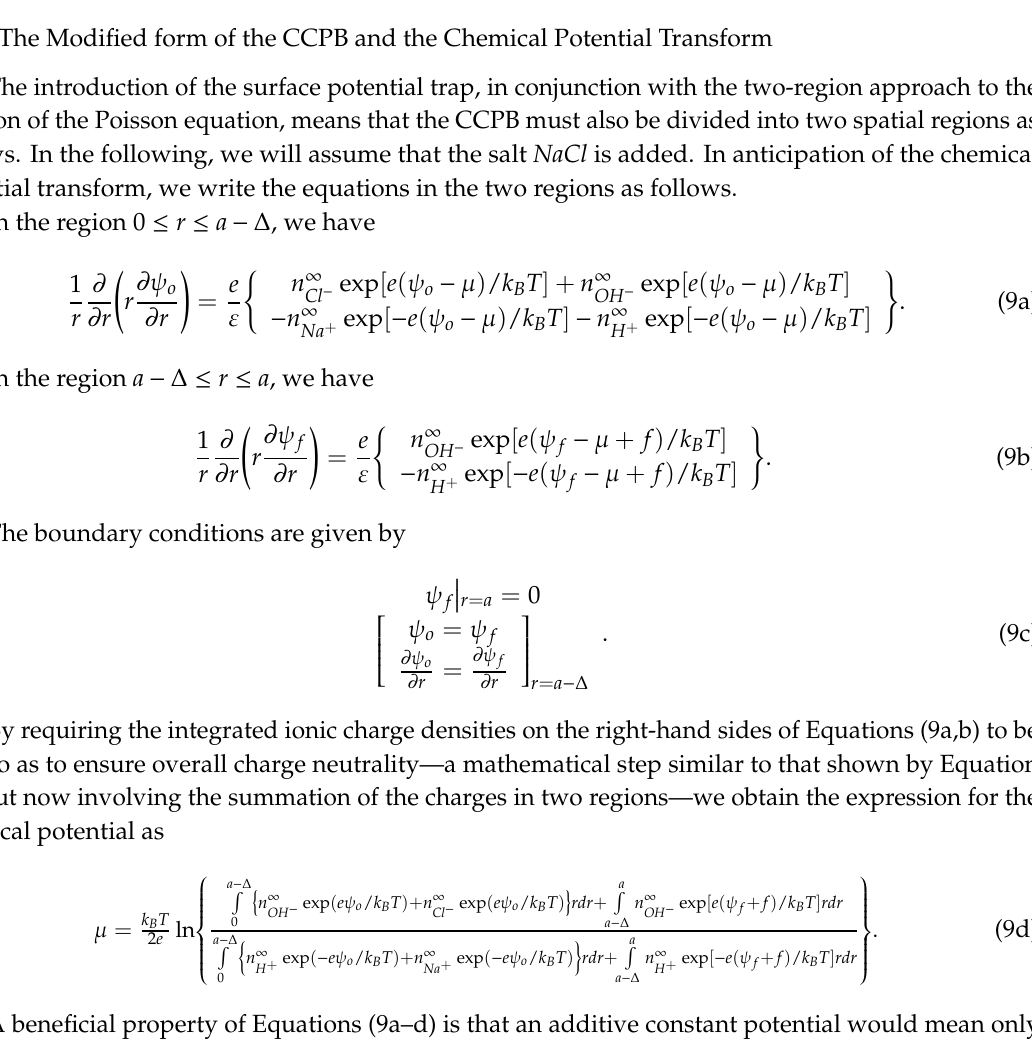
Figure 1. A schematic illustration of the sub-domains in the solution of the charge-conserved Poisson–Boltzmann (CCPB) equation, colored in green and blue. The solutions in the two regions are linked together by the two electrostatic boundary conditions at the interface, denoted by the red line. This division of the computational domain is to ensure that no surface-non-specific salt or bu ff er ions can enter the surface potential trap. The latter has a width of ∆ . This physical condition is especially important in modeling the isoelectronic point and its related properties. Adapted from